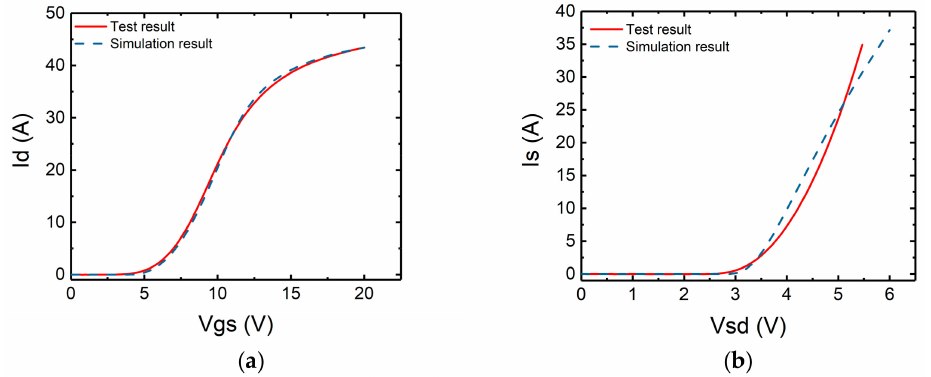
Figure 14. Comparison of ( a ) transfer characteristics, ( b ) body diode characteristics, between simulation and test